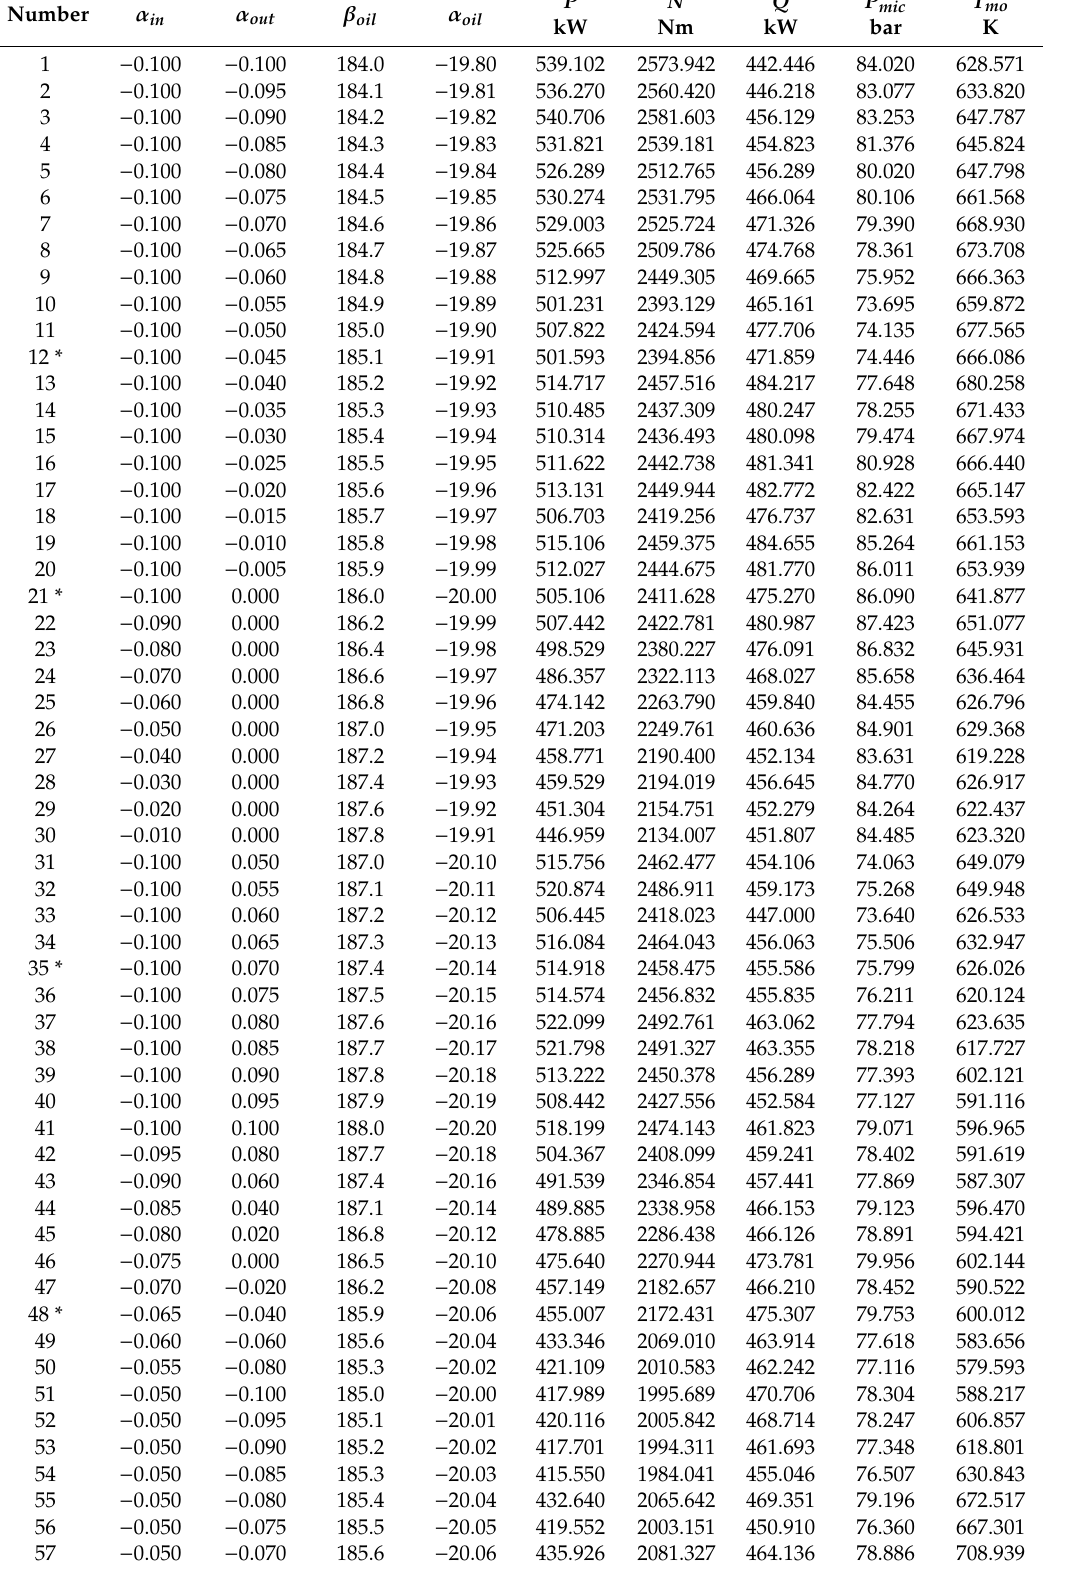
Table A1. Whole dataset for the RBF neural network